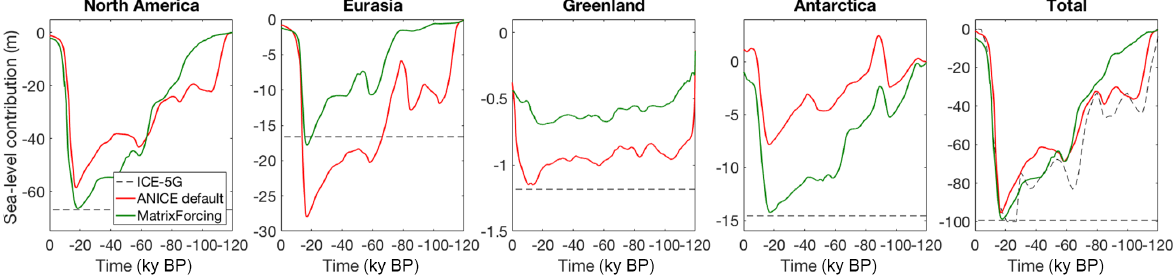
Figure 7. Global mean sea-level contributions over time for the four individual ice sheets, as well as the global total, for the LGC benchmark experiment (green) and the default ANICE control run (red) compared to the ICE-5G sea level at the LGM for the four individual ice sheets and throughout the last glacial cycle for the global sum (dashed line).